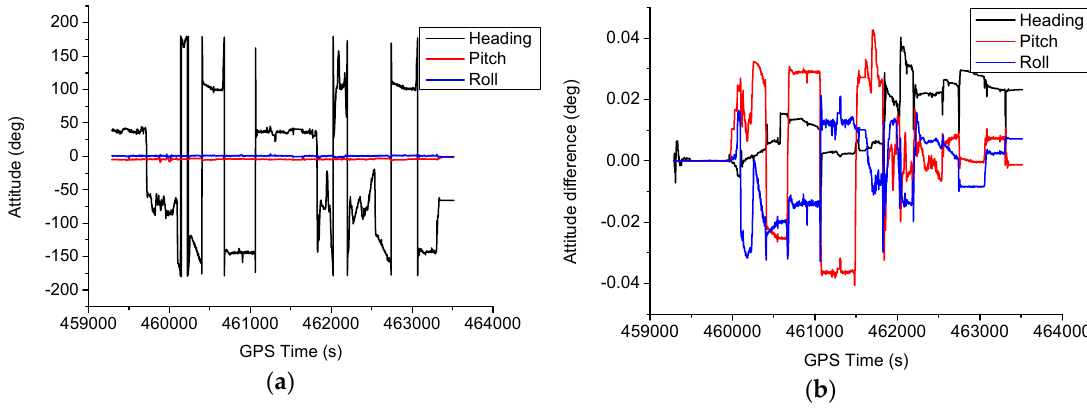
Figure 14. Attitude estimates and difference for the test. ( a ) Attitude estimates; ( b ) Attitude difference.